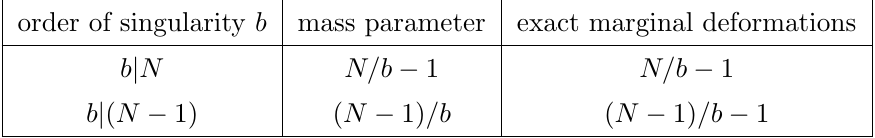
Table 2 . Summary of mass parameters and number of exact marginal deformations in A N (cid:0) 1 .